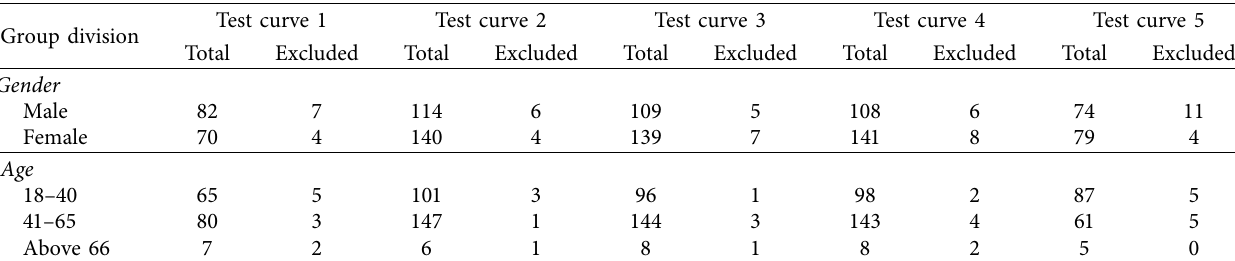
Table 2: Statistical description information.